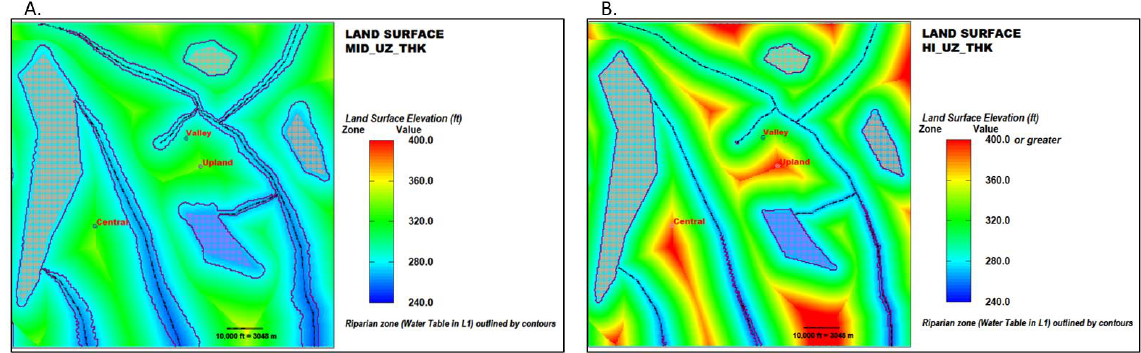
Figure 3. A comparison of the land surface elevations for the ( A ) MID_UZ_THK and ( B ) HI_UZ_THK models. Land surface elevation for each model cell is proportional to its distance from the nearest surface water body. The proportionality constant is 1.5 ft/300 ft (0.005) for the MID_UZ_THK simulation and 3.0 ft/300 ft (0.01) for the HI_UZ_THK simulation. The land surface does not directly enter into the NO_UZ_THK solution, since the UZ is not simulated and therefore no attenuation of the infiltrating signal is realized. The riparian zone contours correspond to conditions at the end of spin-up.